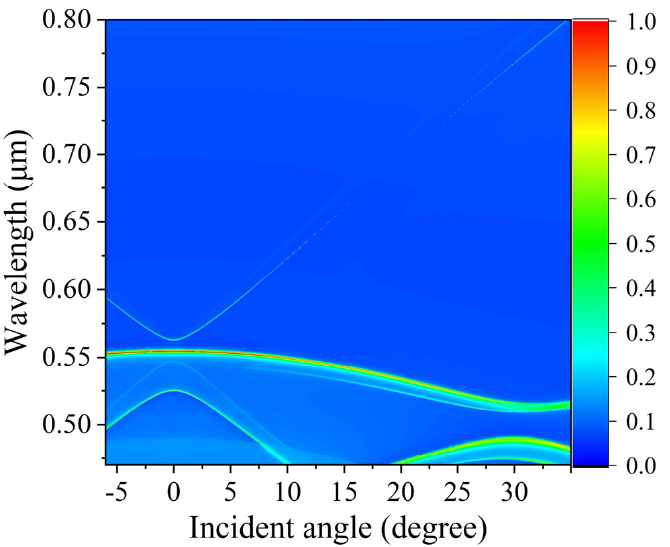
Figure 9. Re fl ectance spectra of the metasurface with center position shifting by 0.05 µm in y direc- tion of A 1 and by 0.05 µm in − y direction of A 2 . a = 0.336 µm, L 1 = L 2 = 0.2 µm, W 1 = W 2 = 0.1 µm.